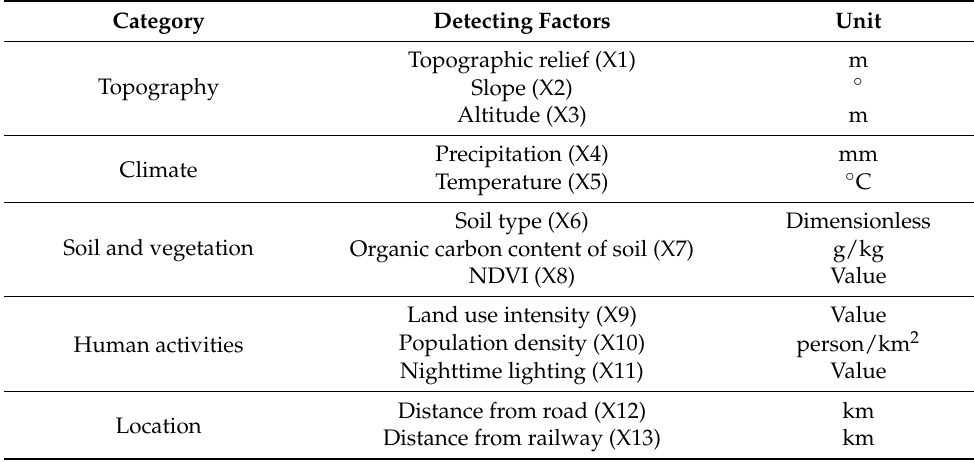
Table 2. GeoDetector indicator system and unit.